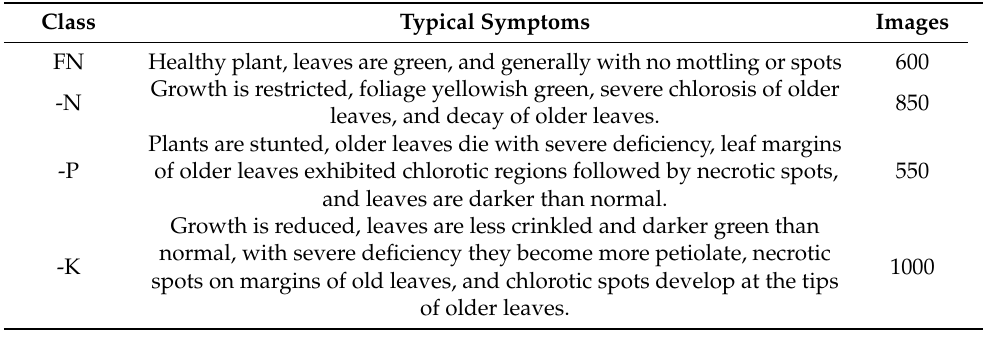
Table 3. Typical symptoms of FN, -N, -P, and -K in lettuce throughout the growing period and the number of images acquired for each class.